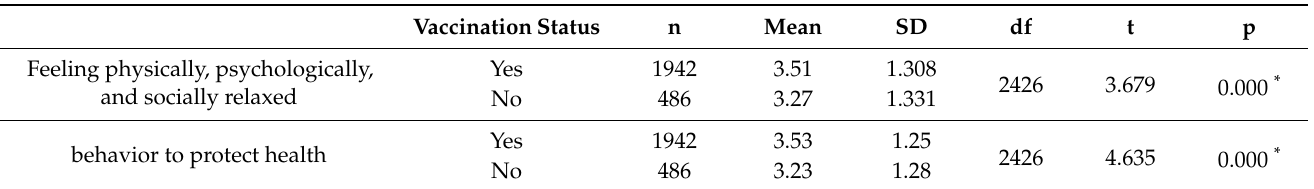
Table 3. The relationship between feeling physically, psychologically, socially relaxed and behavior to protect health and vaccination